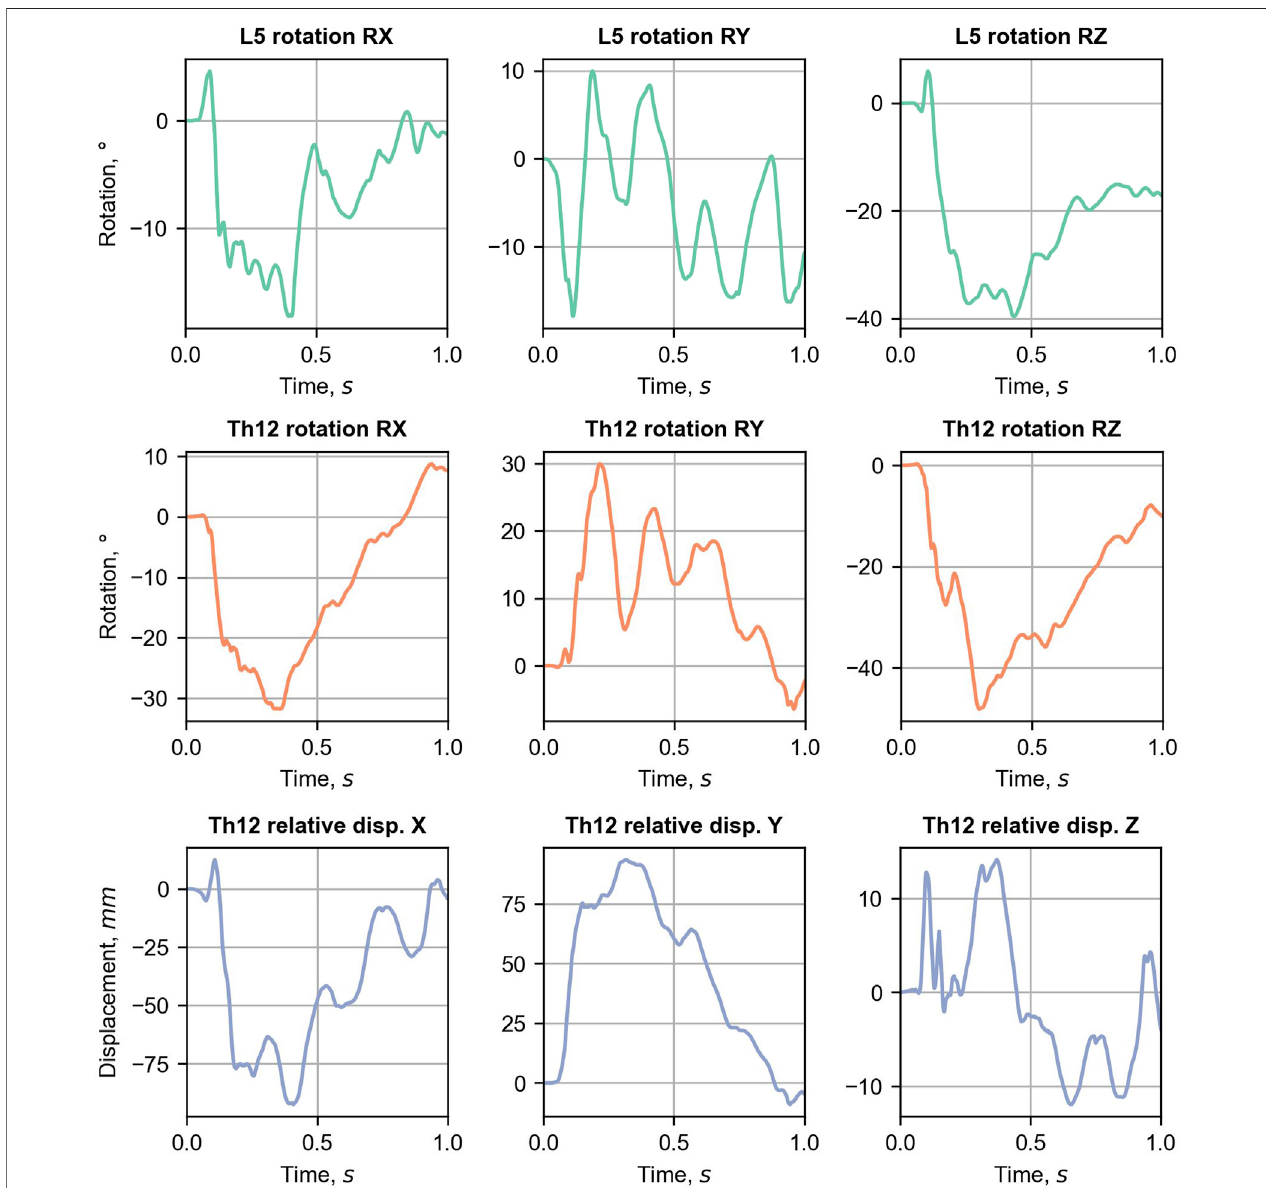
FIGURE 5 | Displacement and rotation curves extracted from the global L-spine